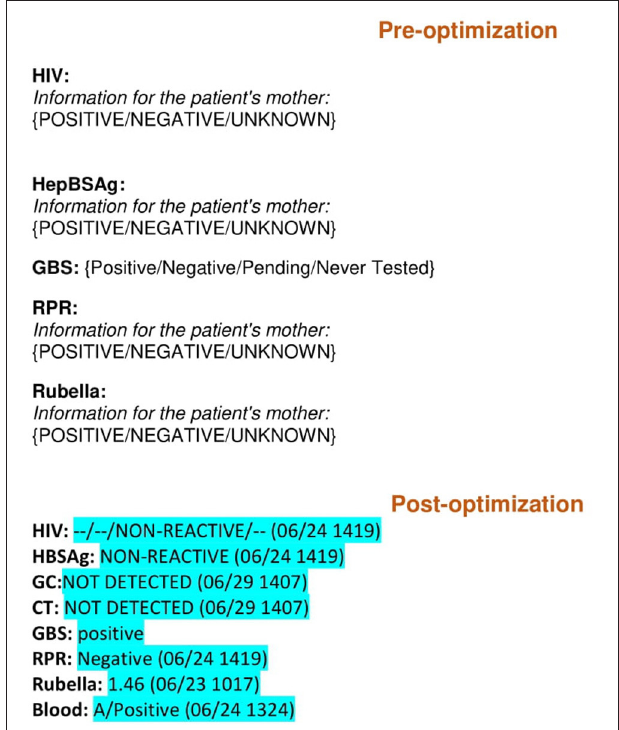
FIGURE 2 | Maternal labs comparison pre and post note optimization blue highlight: Auto generated data. {}: Pick list. Epic codes are omitted. HIV, Human immunodeficiency virus; HBSAg, Hepatitis B antigen; GBS, Group B streptococcus; RPR, Rapid plasma reagin.